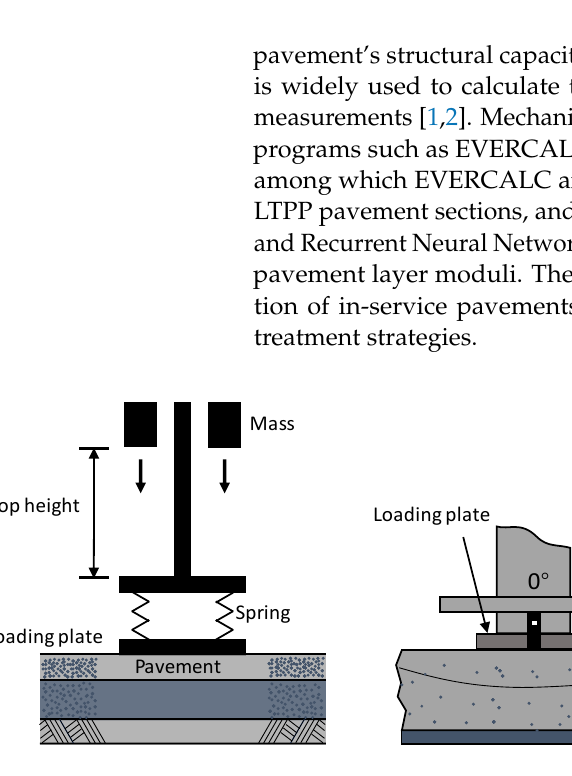
Figure 1. Diagram of FWD test [9] .